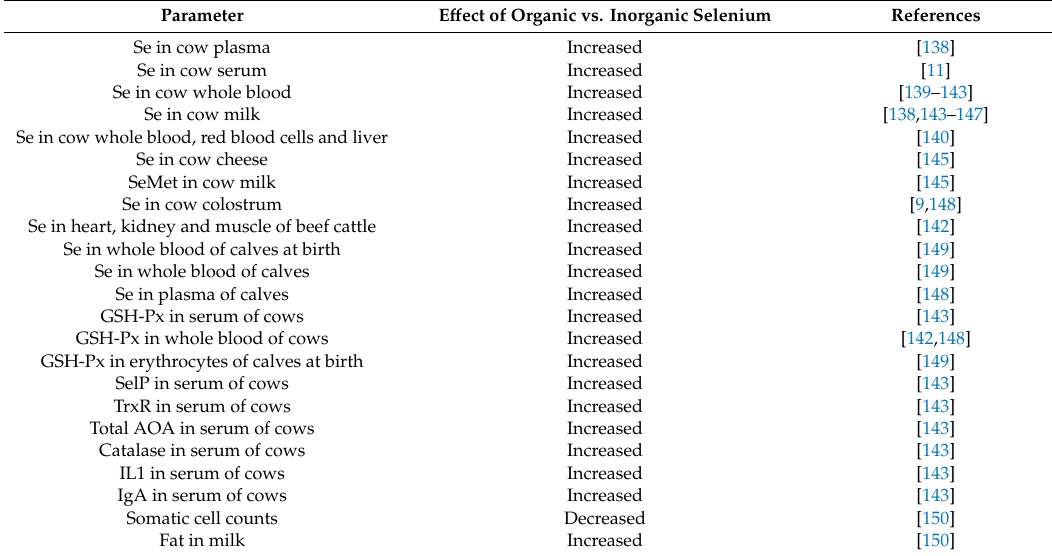
Table 4. Advances of organic selenium for